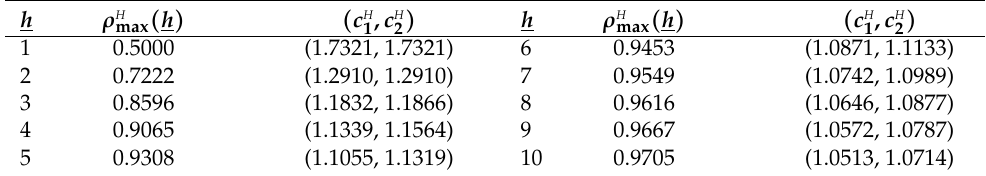
Table 3. The values of ρ H max (with ˜ (cid:101) 1 =